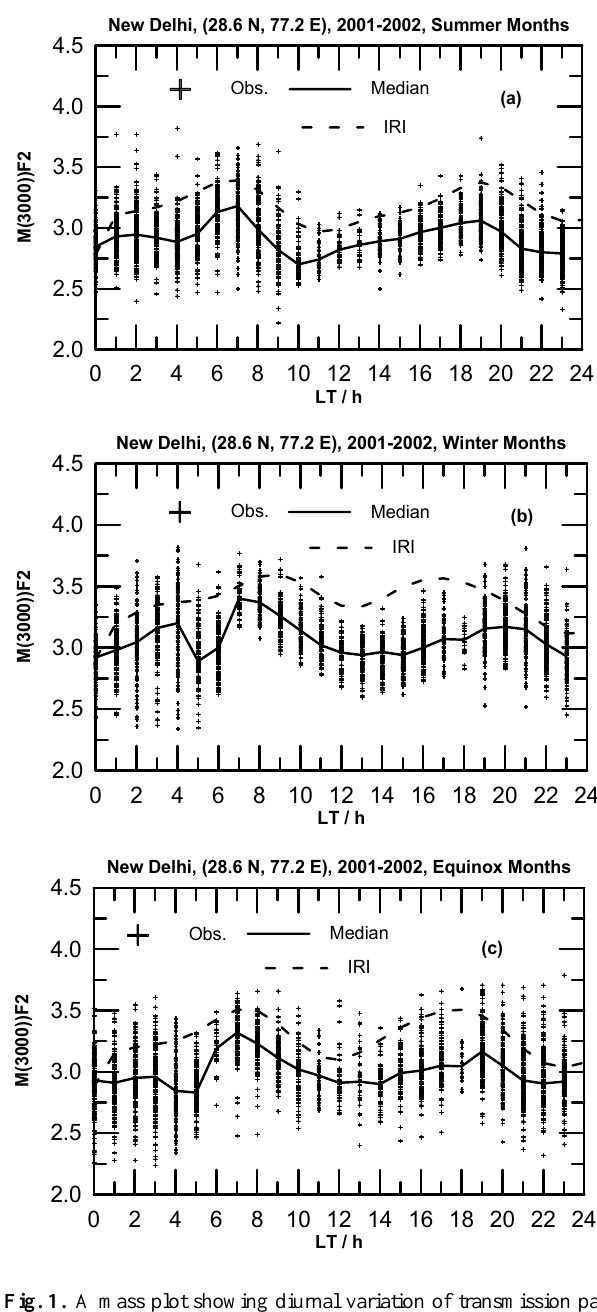
Fig. 1. A mass plot showing diurnal variation of transmission pa- Fig. 1 rameter M(3000)F2, obtained from manual scaling of data using digital ionosonde, over New Delhi, (28.6 ◦ N, 77.2 ◦ E), for (a) sum- mer, (b) winter and (c) equinox. The median values are shown as a solid line. The IRI predicted values are shown as a dashed